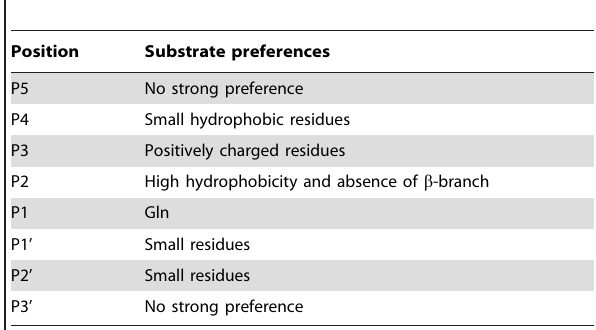
among all 3CL pro